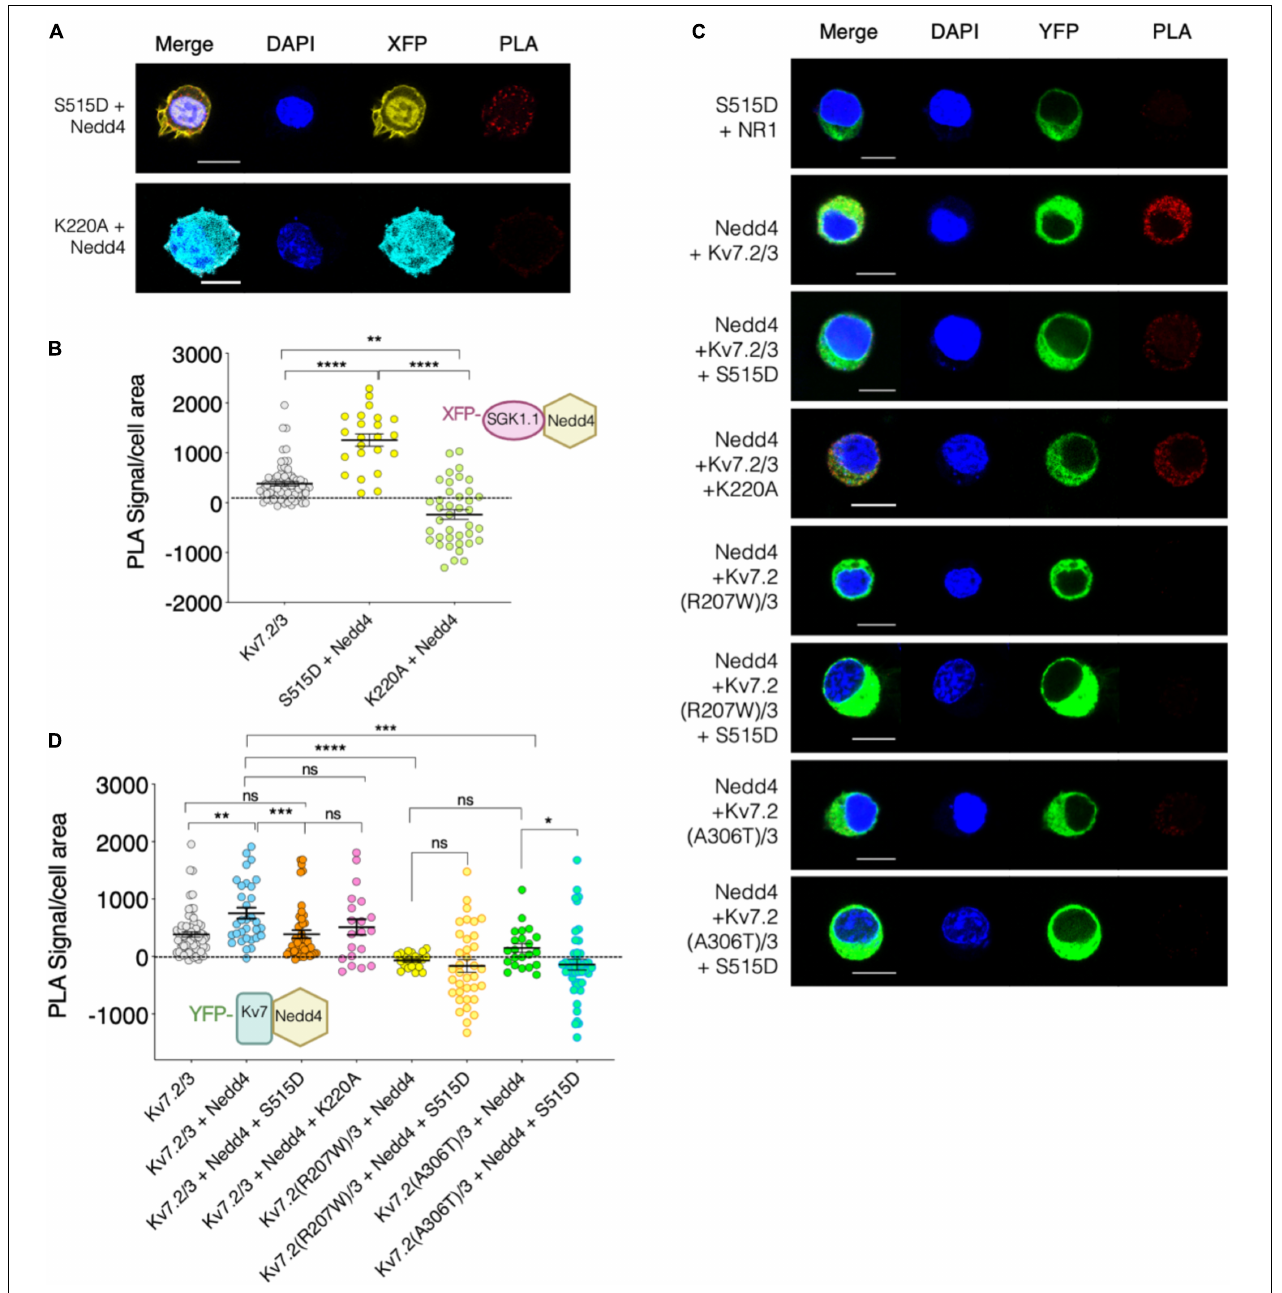
FIGURE 6 | Kv7.2/3 heteromeric channel is located in close proximity to Nedd4-2 and this association weakens in presence of activated SGK1.1. (A–C) Representative images of PLA analysis performed on N2a Sgk1 -KO cells transfected with the indicated constructs. Cells transfected with SGK1.1 (S515D) and NR1 were used as negative control (dotted line at 0 in B,D ). Bars correspond to 10 µ M. (B–D) Quantification of PLA positive signals for each condition (ANOVA Kruskal Wallis test, ns, not significant; * p < 0.05; ** p < 0.01; *** p < 0.0005; **** p < 0.0001). Each dot represents an individual cell from at least three independent